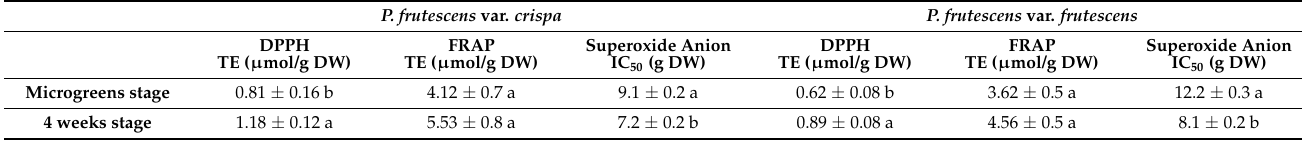
Table 2. Antioxidant activity of the P. frutescens var. crispa (red) and var. frutescens (green) expressed as Trolox equivalent (TE µ mol/g DW) for DPPH and FRAP, and as IC 50 (g DW) for the superoxide anion scavenging activity